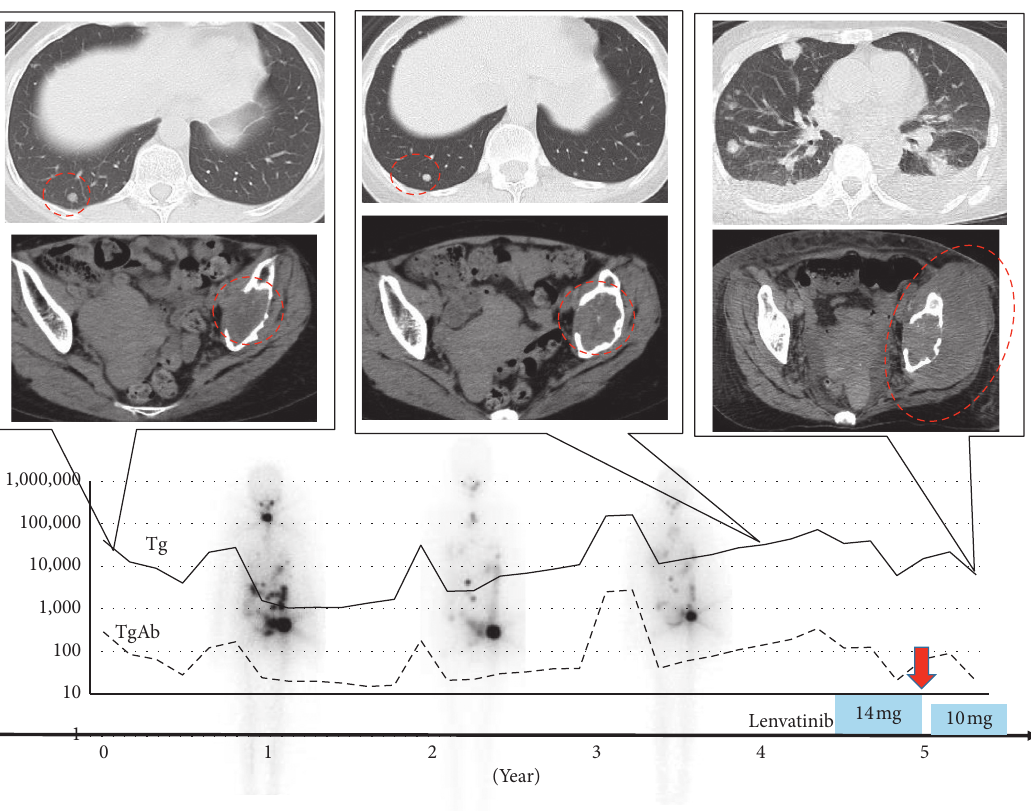
Figure 1: Clinical course of Case 1. The upper image is a chest computed tomography (CT) image. Although lung metastasis did not change after three courses of radioactive iodine (RAI) treatment, the patient’s condition became progressive disease after anaplastic transformation and bilateral pleural effusion accumulated. The lower image is a CT image of the pelvis, and the left iliac metastasis increased rapidly after anaplastic transformation. The graph below the image shows the transition of thyroglobulin and antibodies, the timing of lenvatinib treatment and the dose. Whole body scintigraphy images after three RAI treatments are also shown in the background. RAI uptake is decaying. The red dotted circle indicates the lesion. The red arrow indicates the time of anaplastic